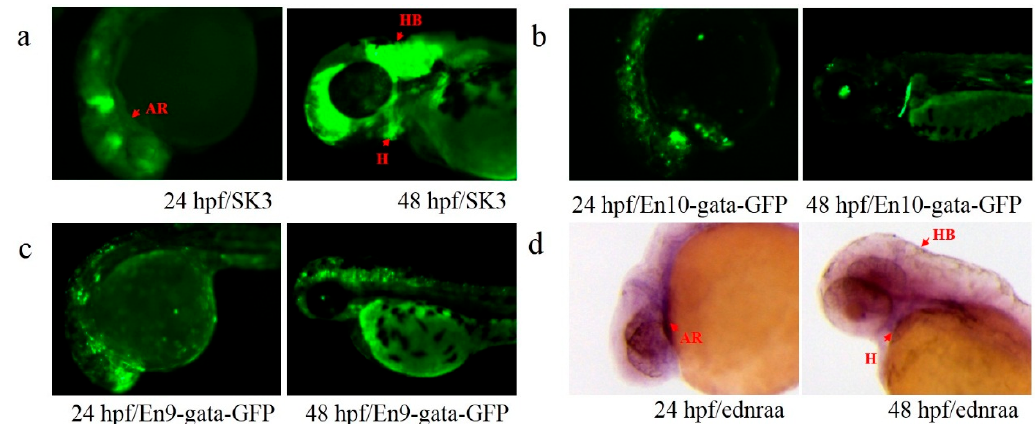
Figure 6. Expression patterns of En and endogenous ednraa in SK3. ( a ) GFP expression of line SK3 at 24 and 48 hpf; ( b , c ) GFP expression of the embryos injected with plasmids carrying En10 and En9 at 24 and 48 hpf; ( d ) gene expression of ednraa at 24 and 48 hpf. Red arrows indicate the similar patterns in arches (AR), hindbrain (HB) and heart (H).